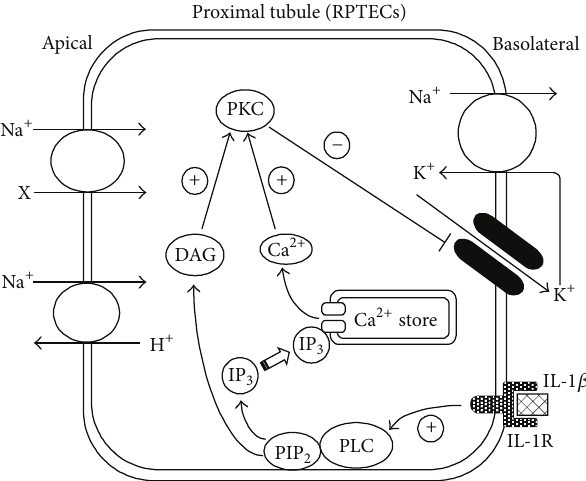
Figure 2: Illustration of the acute effect of IL-1 𝛽 on the 40pS K +